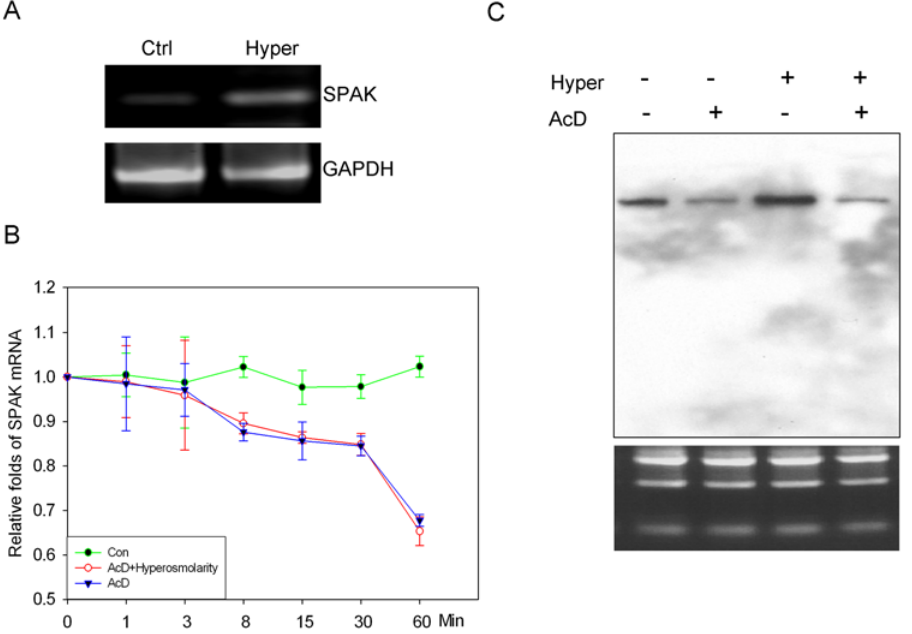
Figure 4. Hyperosmolarity regulates SPAK expression at the transcriptional level. A. Nuclear run-on assay indicated the increase of SPAK mRNA transcription under the treatment of hyperosmolarity, with the mRNA transcription of GAPDH as internal control. B. Hyperosmolarity does not change SPAK mRNA stability; the percentage of remaining SPAK mRNA is shown at the different time point. Solid circle represents the value of real time PCR with the samples from Caco2-BBE cells without treatment, open circle represents the value of real time PCR with the samples from Caco2- BBE treated with actinomycin D, solid triangle represents real time PCR with the samples from Caco2-BBE treated with actinomycin D and hyperosmolarity. C. Northern blot analysis of total RNA from Caco2-BBE cells, Lane 1, no treatment, Lane 2, AcD, Lane 3, hyperosmolarity, and Lane 4, AcD and hyperosmolarity. The lower RNA electrophesis shows equal loading of each condition. doi:10.1371/journal.pone.0005049.g004 PLoS ONE |